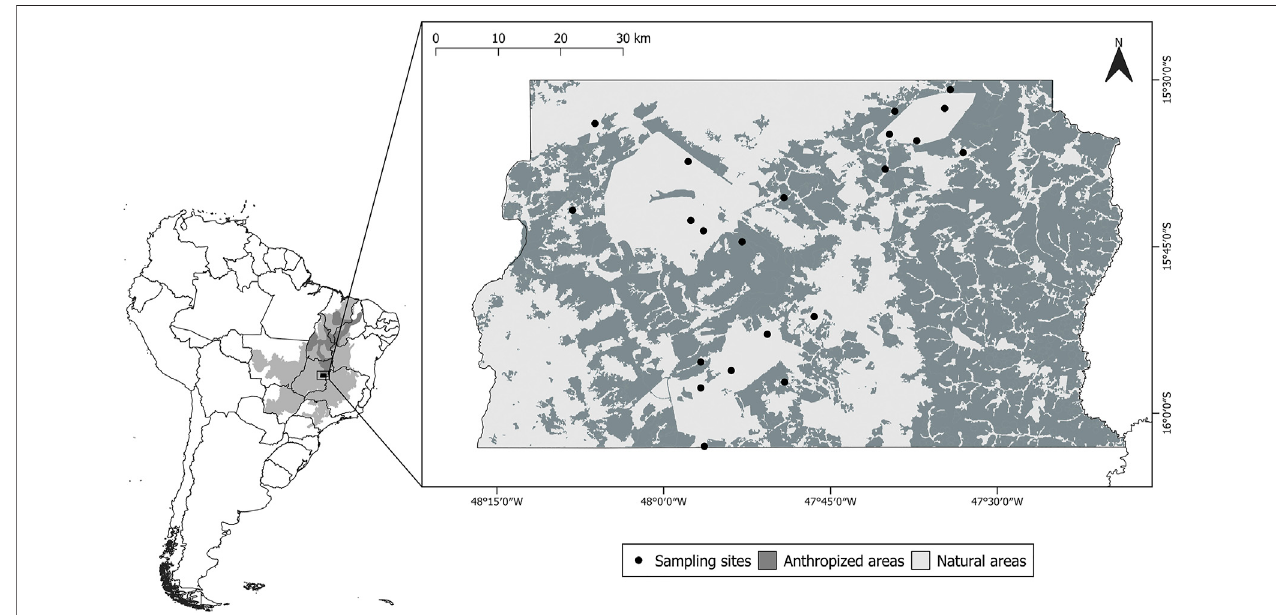
FIGURE1| LocationofthestudyareawithinSouthAmerica.InsmallmaplightgreyrepresentstheCerradobiomeanddarkgreyrepresentstheCerradoBiosphere Reserve. In large map light grey represents natural areas, dark grey represents anthropized areas, and black dots represent sampling sites.